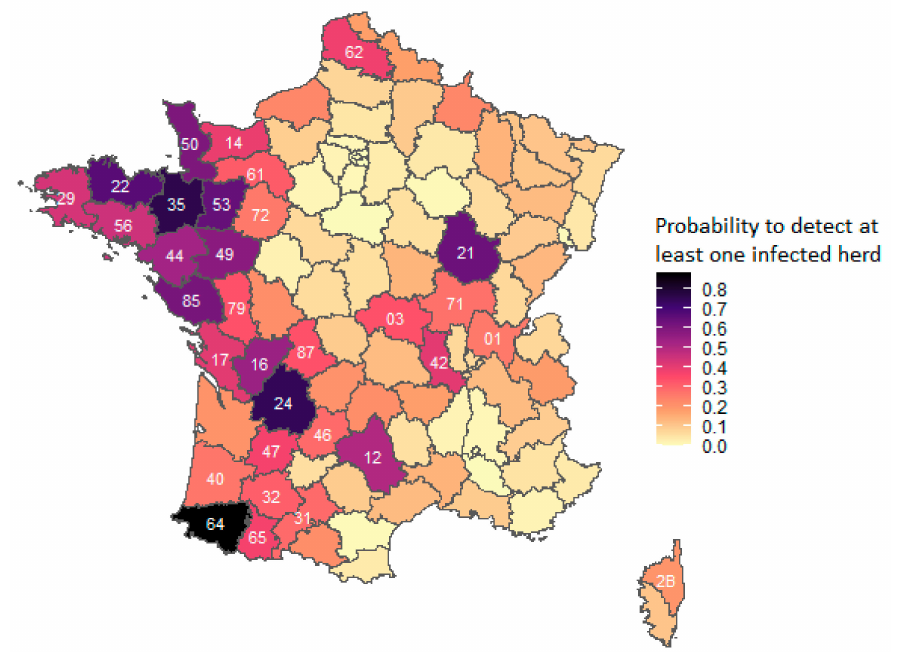
Figure 3. Estimation of the probability of detecting, via ante-mortem surveillance, at least one infected herd in the French administrative areas for a prevalence set at 0.1%. Numbers on the map are the administrative numbers on the areas. For more clarity, only the number of areas mentioned in the text or presented in Figures 4 and 5 are